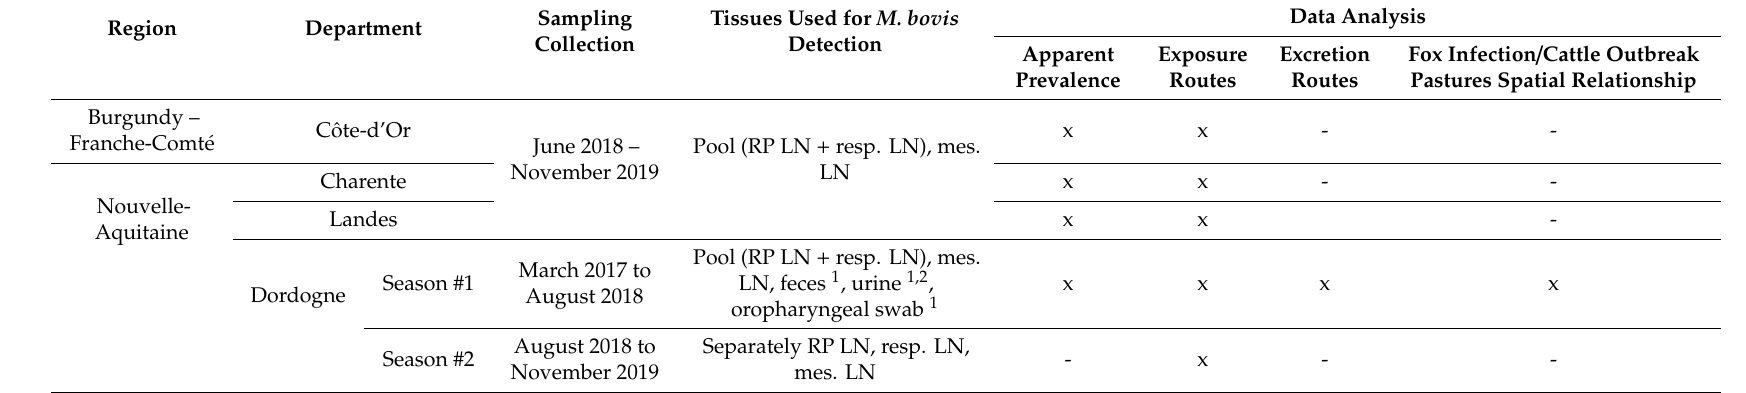
Table 2. Summary of the material and methods used in the four study